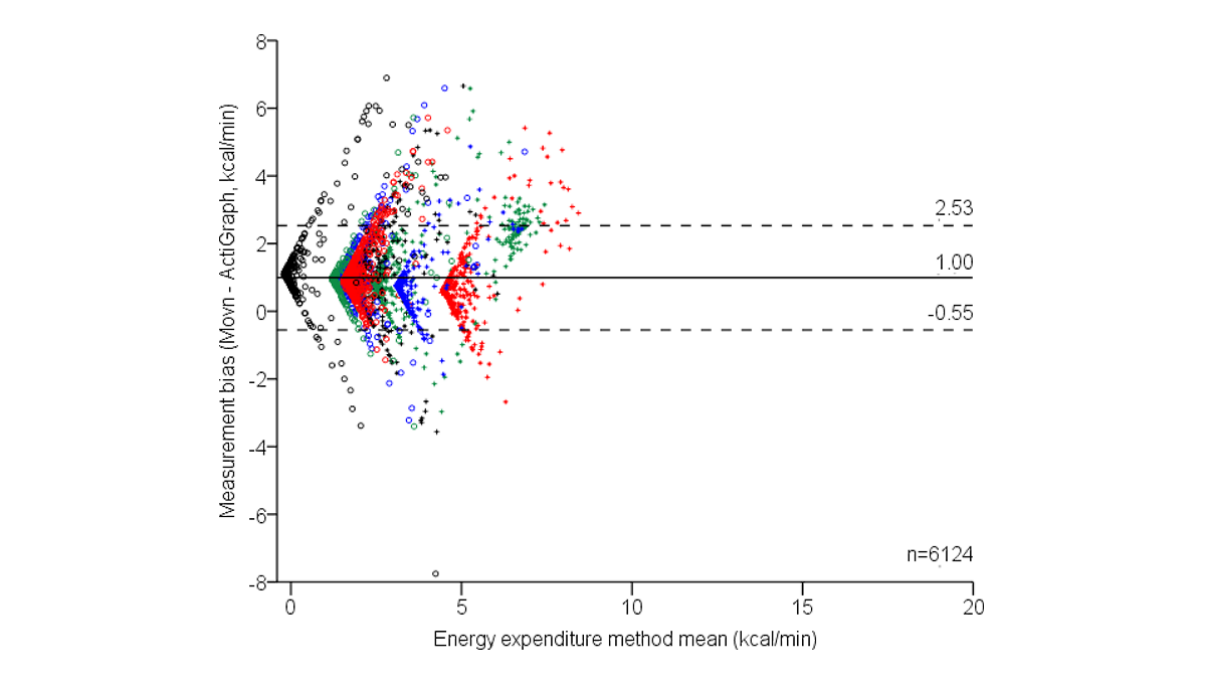
Figure 6. The 95% limits of agreement for phase 1 free-living convergent energy expenditure measurement biases; categorized by individual participants who recorded ≥ 10 hours activity data per